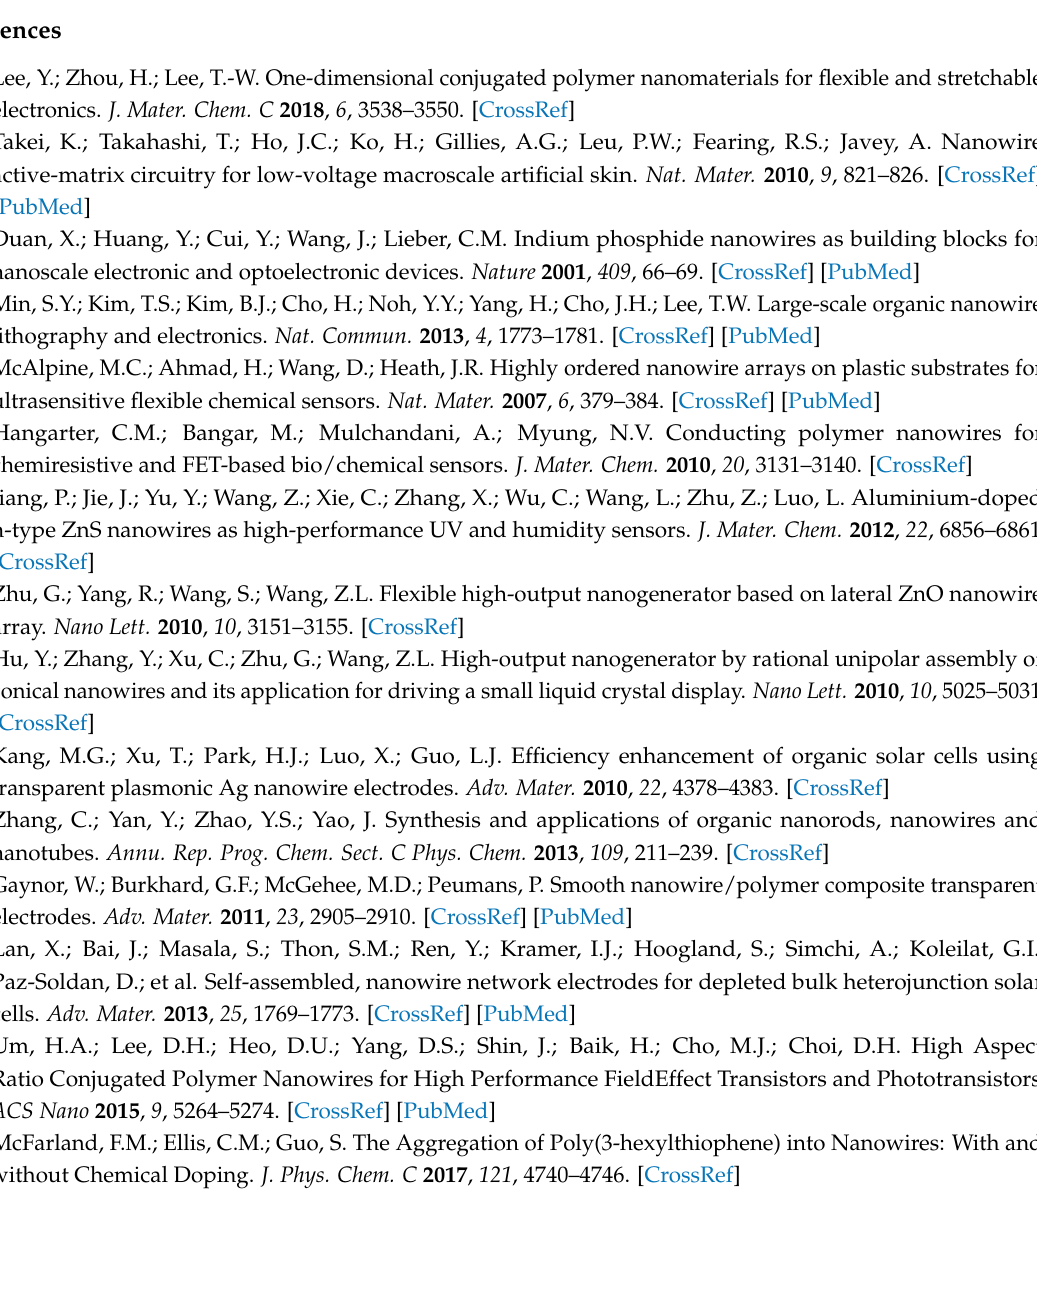
Figure S1: AFM images of spin-coated morphology of PDI 8 -CN 2 at a concentration of 5 mg/mL on Si/SiO 2 substrate, Figure S2: Profile image across the white line in AFM images of PDI 8 -CN 2 nanowires from 1:20 w / w solution on Si/SiO 2 , Figure S3: Optical microscope image of PDI 8 -CN 2 nanostrutures from 1:50 w / w solution on Si/SiO 2 substrate after the SVA process, Figure S4: XRD pattern of the prepared nanowires from the SVA treating PDI 8 -CN 2 /PMMA nanostructure, Figure S5: UV-vis absorption and photoluminescence spectra of PDI 8 -CN 2 solution (black), nanowire (red), Figure S6: Confocal fluorescence microscope images of spin-coated PDI 8 -CN 2 nanostructures of 0.3 mg/mL 1,2-dichlorobenzene solution on Si/SiO 2 substrate, Figure S7: Optical microscope images of spin-coated pure PDI 8 -CN 2 system with different concentrations in 1,2-dichlorobenzene on Si/SiO 2 substrate before and after SVA: (a–c) as-cast; (d–f) after SVA; (a,d) 0.3 mg/mL; (b,e) 1 mg/mL; (c,f) 2 mg/mL. Different scale bars are used for